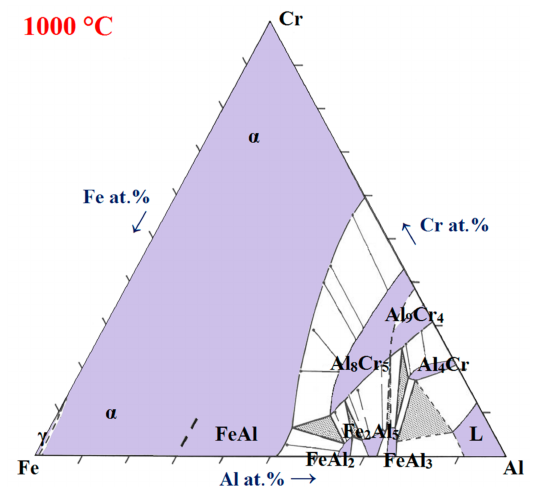
Figure 13. Isothermal section of the Fe-Al-Cr system at 1000 ◦ C. The phase boundary between a-(Fe,Al) and FeAl has not been determined and is therefore given by a broken